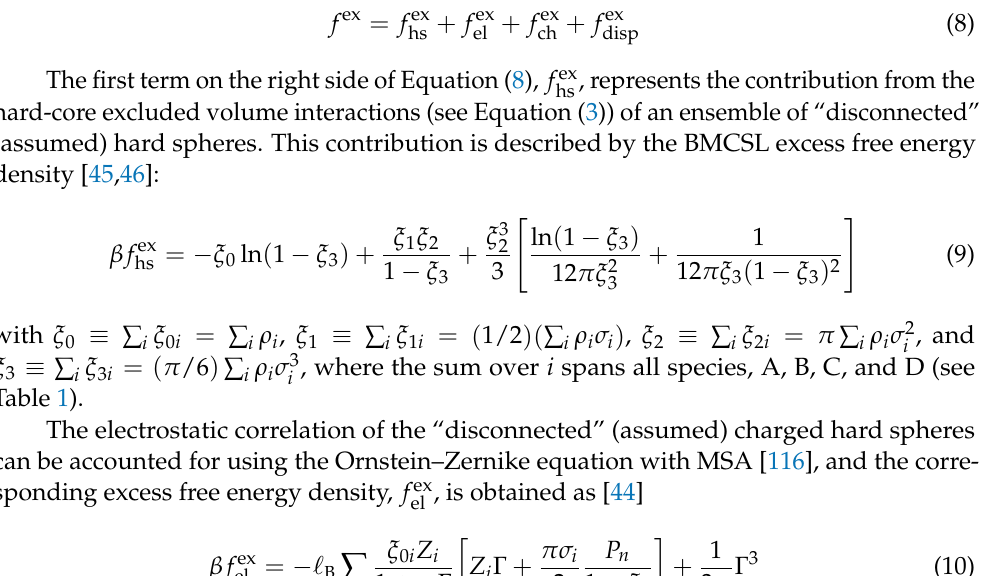
Table 1. Summary of the different species considered in this work. A = Charged segments of the polymer; B = Neutral segments of the polymer, C = Counterions of the charged segments of the polymer and salt co-ions, D = Co-ions from the added salt (assumed to be C + D). Component A B C D Number density ρ A ρ B Valence Z A Z B = 0 The excess Helmholtz free energy density is provided by [91]: